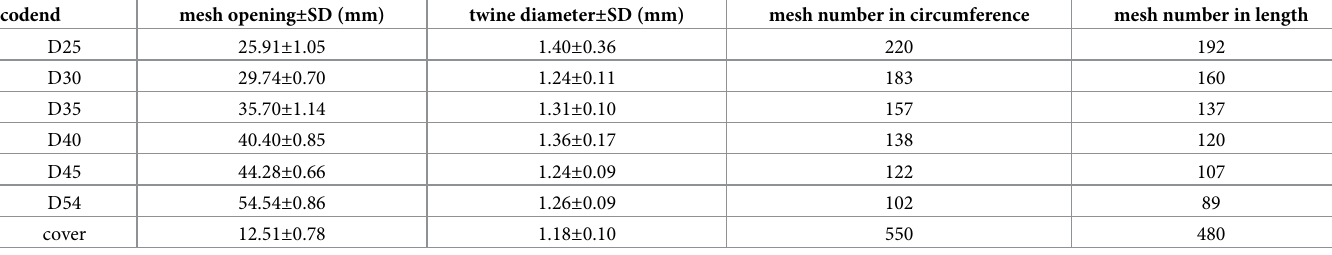
Table 1. Overview of specifications of the tested codends.